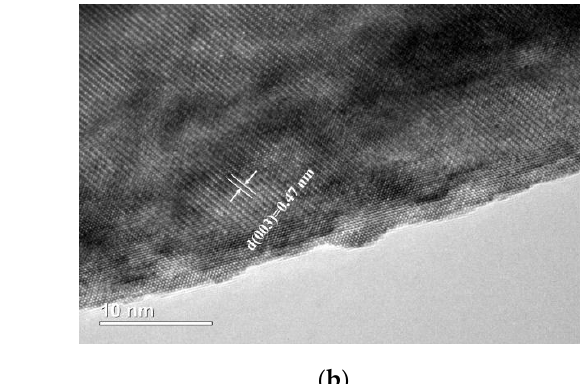
Figure 3. Particle morphology and particle size distribution analysis. (1) Scanning electron microscope (SEM) images of